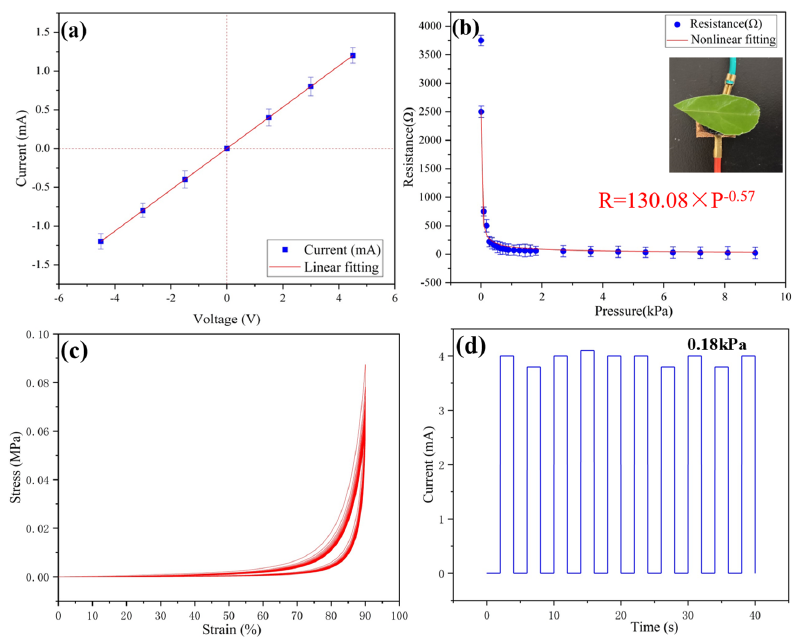
Figure 2. ( a ) Variations in sensor current with voltage without applied pressure; ( b ) resistance of the sensor with different applied pressures; ( c ) stress-strain curves of ultra-flexible silica aerogel for 20 cycles; ( d ) stability test of the conductive aerogel sensing property at 0.18 kPa. In order to evaluate the pressure sensing performance of the multiparameter sensor, it is very important to evaluate several key parameters of the sensor, such as pressure, resistance change, and sensitivity. The pressure sensitivity of the device is defined as Equation (1):